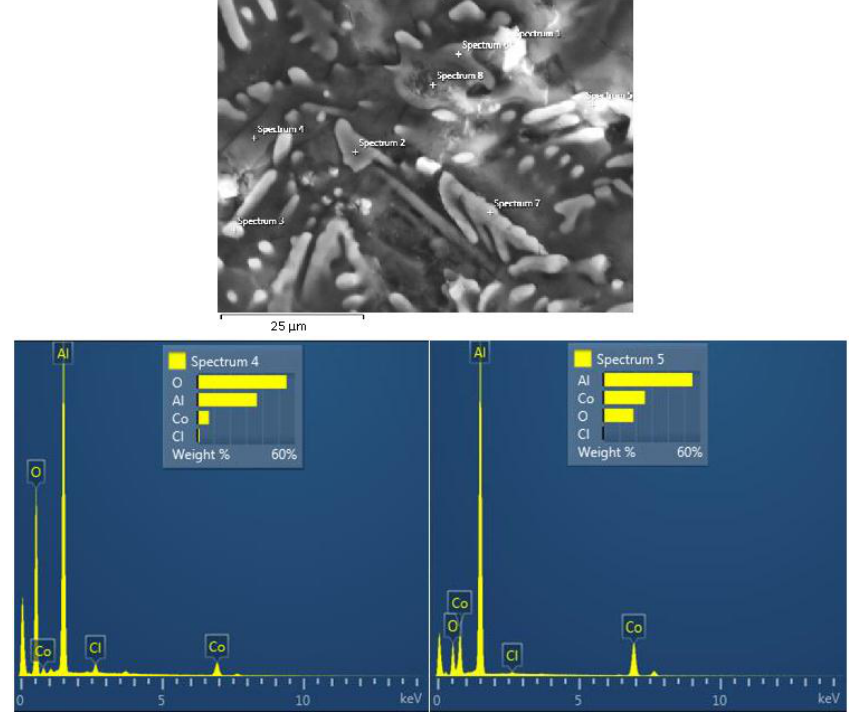
Figure 7. Cross‐section (SE mode) of Al‐7 wt.% Co after cyclic polarization (3.5 wt.% NaCl, 25 °C) and EDX analysis in the (Al) phase (spectrum 4) and the Al 9 Co 2 phase (spectrum 5).